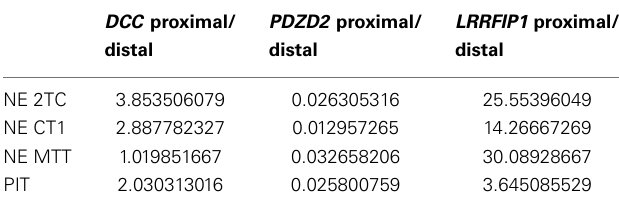
Table 6 | Expression ratio of (short isoform/long isoform) derived from Q-RT-PCR data.